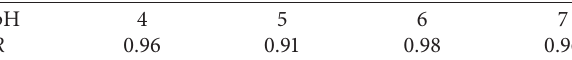
Table 8: Correlation coefficient R between test value and calculated value.